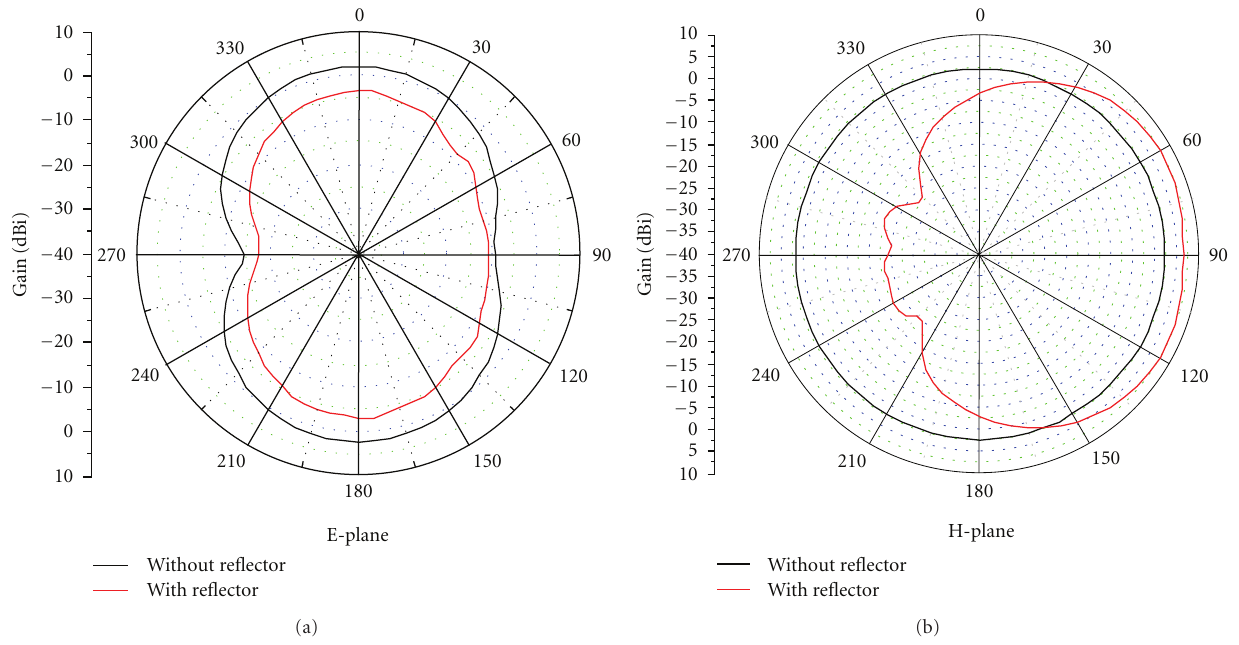
Figure 11: Simulated radiation diagrams of dipole with and without reflector at 2.44 GHz.